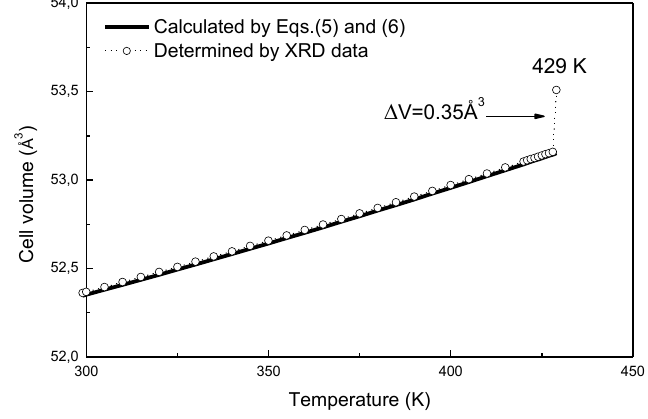
Figure 7. In cell volume V vs. temperature determined by XRD. The values calculated by Equations (5) and (6) are reported for